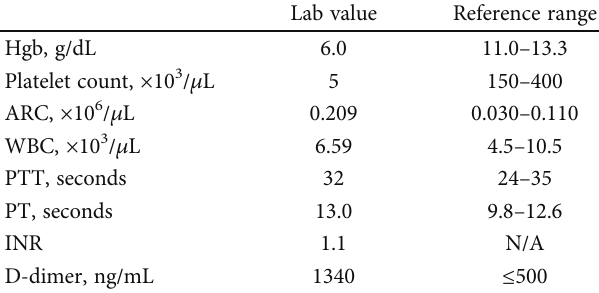
Table 1: Admission laboratory